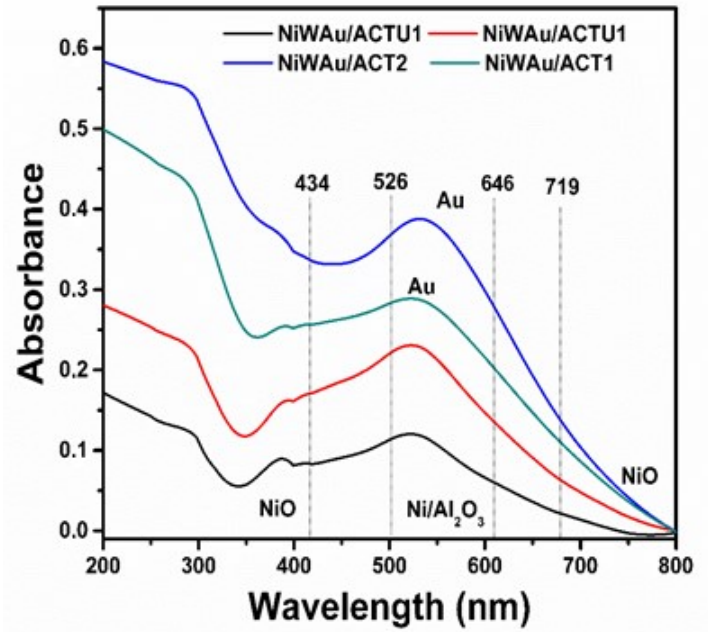
Figure 6. UV-Vis with diffuse reflectance of solids (DRS) for nanomaterials synthesized by the recharge method.